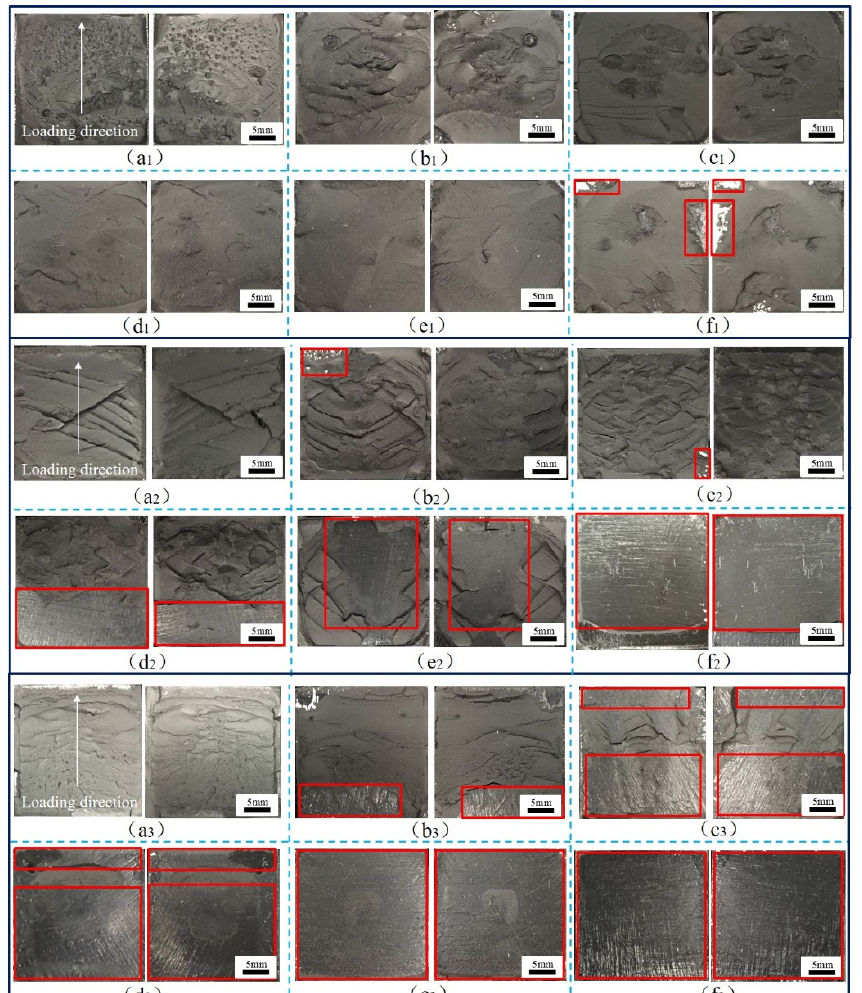
Figure 13. Images of 45° SJs, high temperature: ( a 1 ) 0, ( b 1 ) 6, ( c 1 ) 12, ( d 1 ) 18, ( e 1 ) 24, ( f 1 ) 30 days; room temperature: ( a 2 ) 0, ( b 2 ) 6, ( c 2 ) 12, ( d 2 ) 18, ( e 2 ) 24, ( f 2 ) 30 days; low temperature: ( a 3 ) 0, ( b 3 ) 6, ( c 3 ) 12, ( d 3 ) 18, ( e 3 ) 24, ( f 3 ) 30 days.